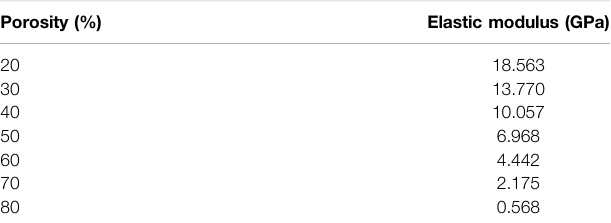
TABLE 3 | Modulus of the elastic modulus of G structural units with different